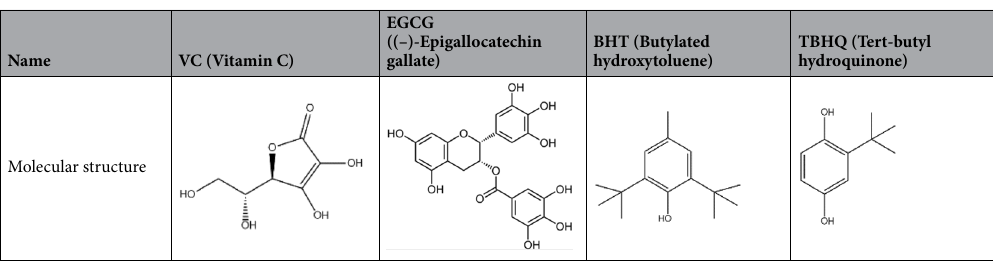
Table 2. Four antioxidant